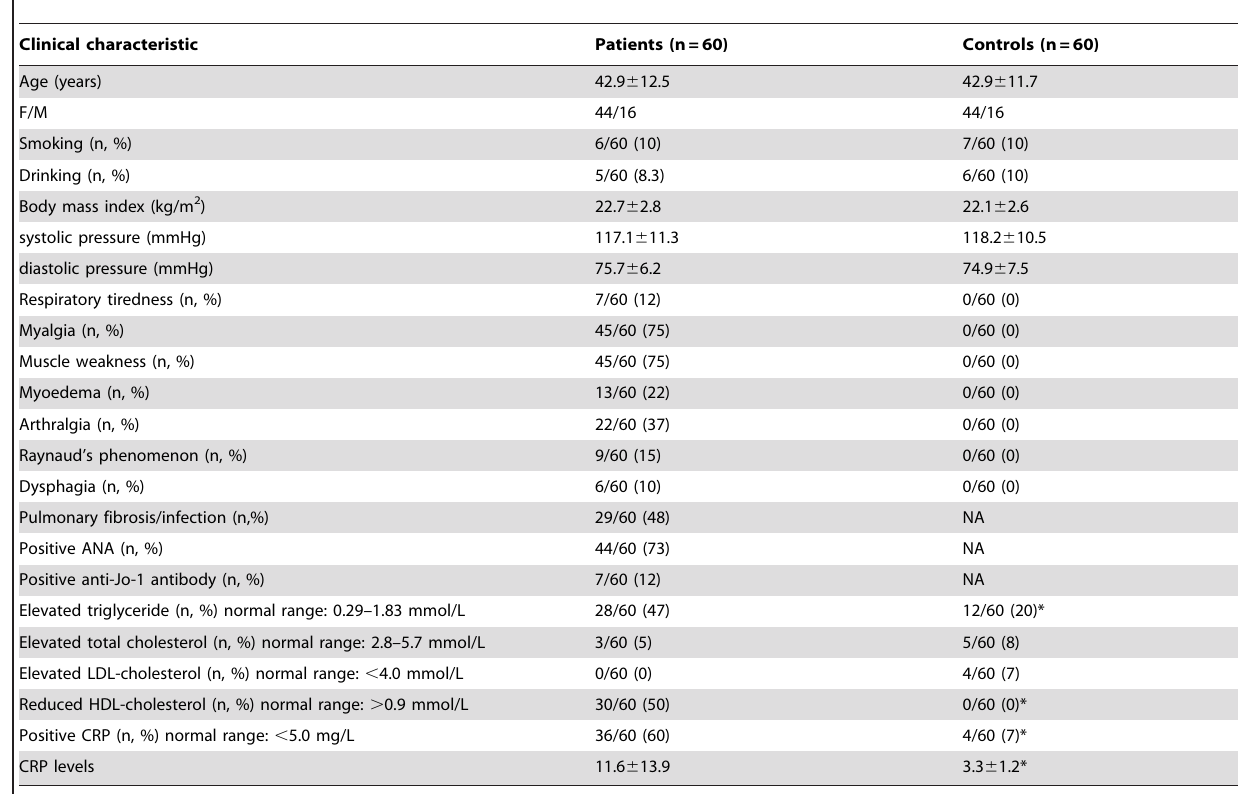
Table 1. Clinical characteristic of untreated patients with early polymyositis and controls.